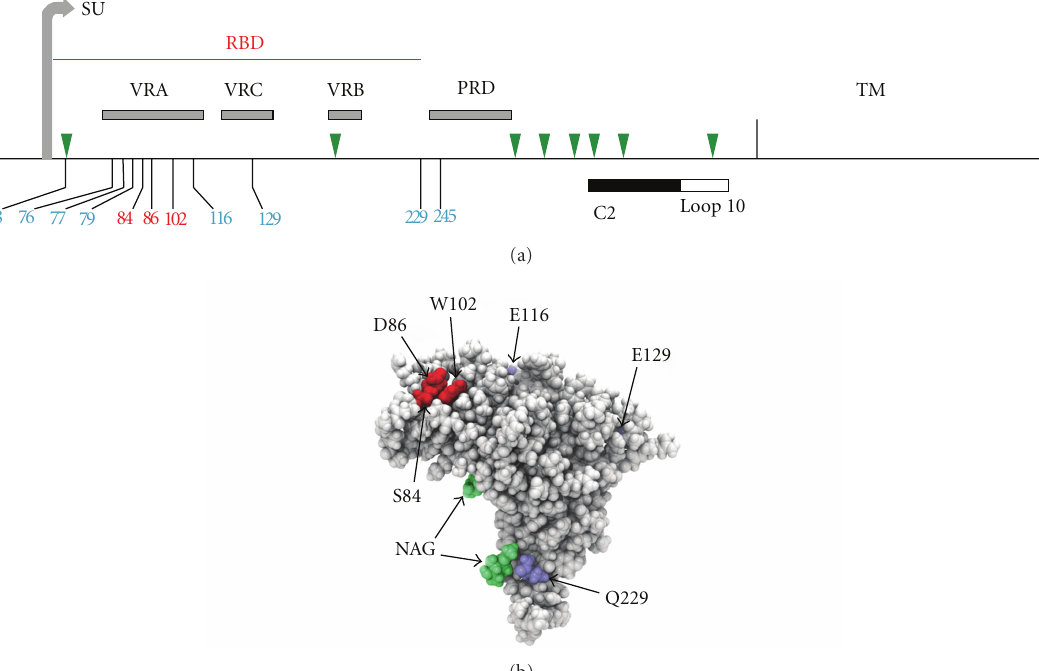
Figure 2: Structure of the FrMLV E-MLV Env gene. (a) Stick figure representation identifies the surface (SU) and transmembrane (TM) domains, the receptor binding domain (RBD) containing three variable regions (VRA, VRB, and VRC), and the proline-rich domain (PRD). Green triangles mark the N-linked glycosylation sites in SU. Vertical lines identify residues with roles in entry; the three residues in red form the binding pocket. The C-terminal segments designated C2 and loop10 have also been implicated in entry [42, 43]. (b) Surface representation of the FrMLV RBD (PDB ID 1AOL) [36], showing the location of the binding pocket (red), additional residues involved in entry (blue), and two N-linked glycosylation sites